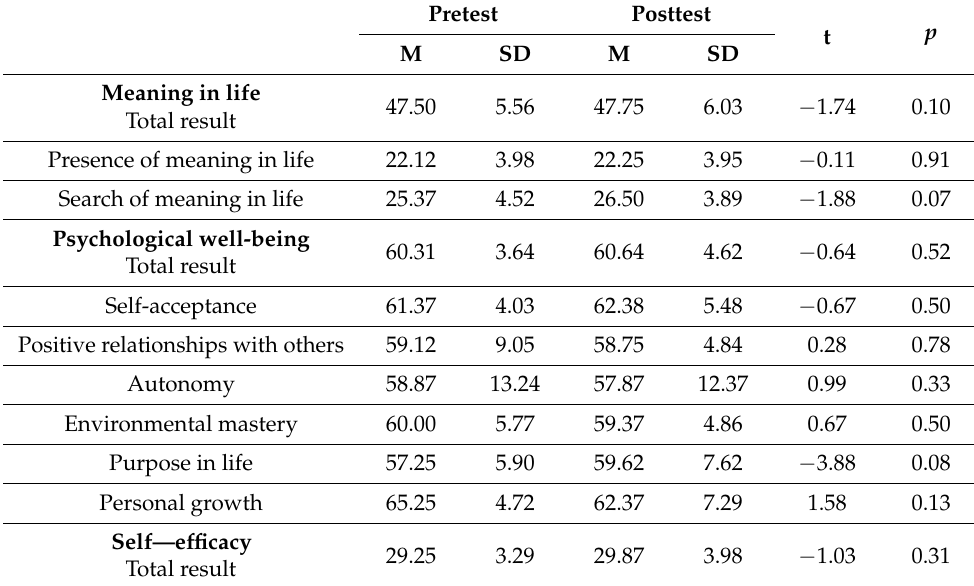
Table 3. Comparison of the level of meaning in life, psychological well-being, and self-efficacy before (pretest) and after a week (posttest) in control group (without intervention) ( n = 40).